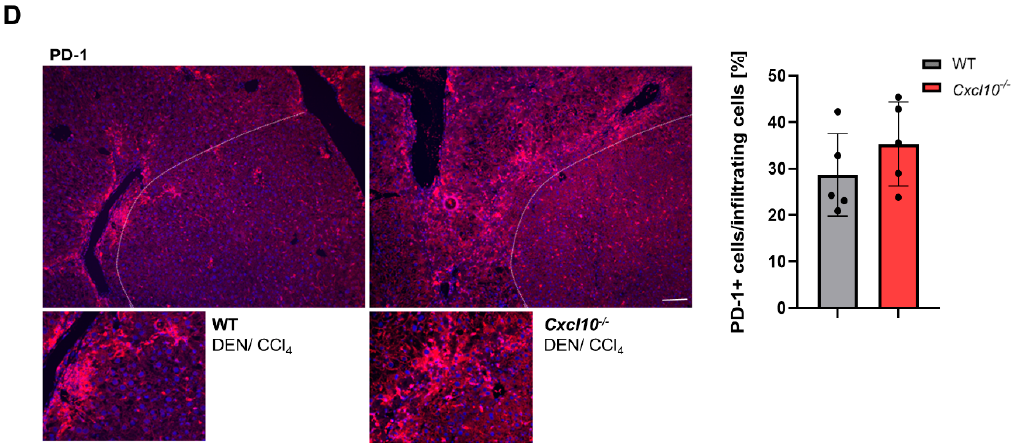
Figure 6. Altered inflammatory tumor microenvironment in Cxcl10 − / − mice in an experimental fibrosis-triggered HCC model; ( A – C ) to analyze the inflammatory microenvironment mRNA expression level of Infy , Il6 , Il1ß , Il12 , Perforin , Granzym B , Pd-l1 , Ctla-4 , Lag3 and Timp3 was quantified by qRT-PCR in macroscopically separated fibrotic, non-tumor liver surrounding tissue (ST) as well as tumor tissue (T) of the DEN/CCl4-treated WT and Cxcl10 − / − mice. The mRNA expression was normalized to the expression of 18S ; ( D ) immunofluorescence staining and quantification of PD-1 of the DEN/CCl4-treated WT animals and Cxcl10 − / − animals (n = 5), (PD-1+ cells/DAPI-positive nuclei of infiltrating cells [%]), PD-1 (red), cell nuclei (blue) (scale bar 100 µ m). Three view fields were counted per sample. Data are expressed as mean ± SEM. Asterisks indicate statistical significance: * p < 0.05, ** p < 0.01.